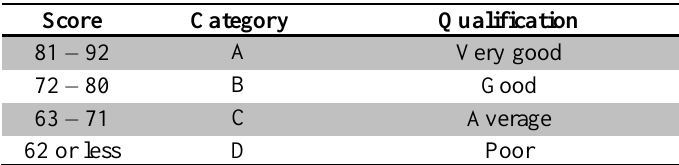
Table 2. The Standard of Scoring